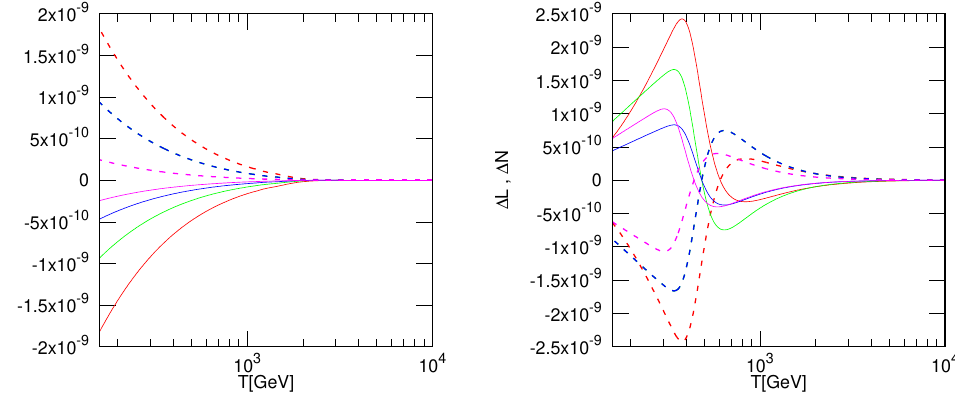
Figure 8 . Time-evolution of asymmetris; solid lines are sum of asymmetries in the left-handed lepton sector and dashed lines are that of the HNL sector. Note that blue and green dashed lines are overlapped. The common mass M = 1 GeV, phases are (cid:12)xed to the values (8.1). Left panel: (cid:1) M = 10 (cid:0) 7 GeV and Im ! = 1. Right panel: (cid:1) M = 10 (cid:0) 7 GeV and Im ! =